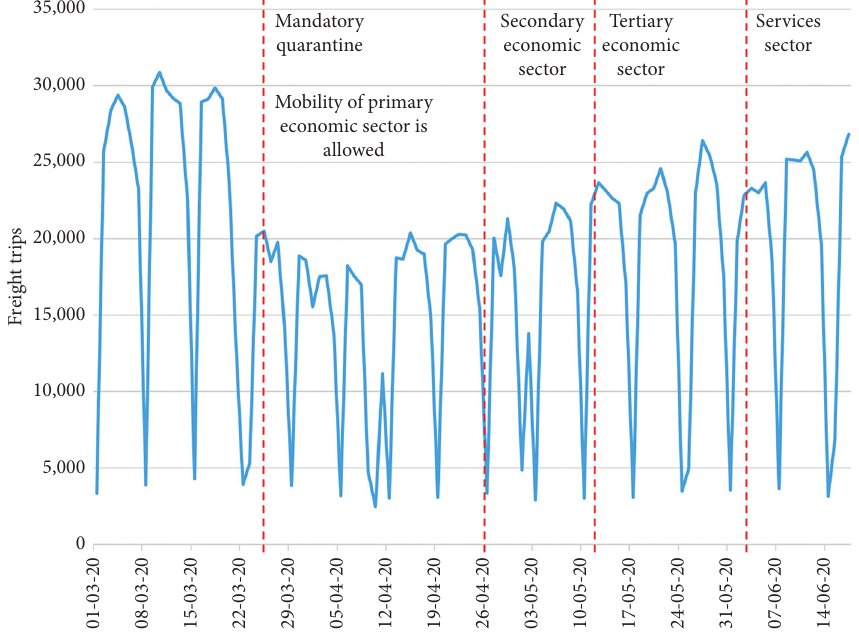
Figure 3: Freight trips in Colombia from March to June 2020.